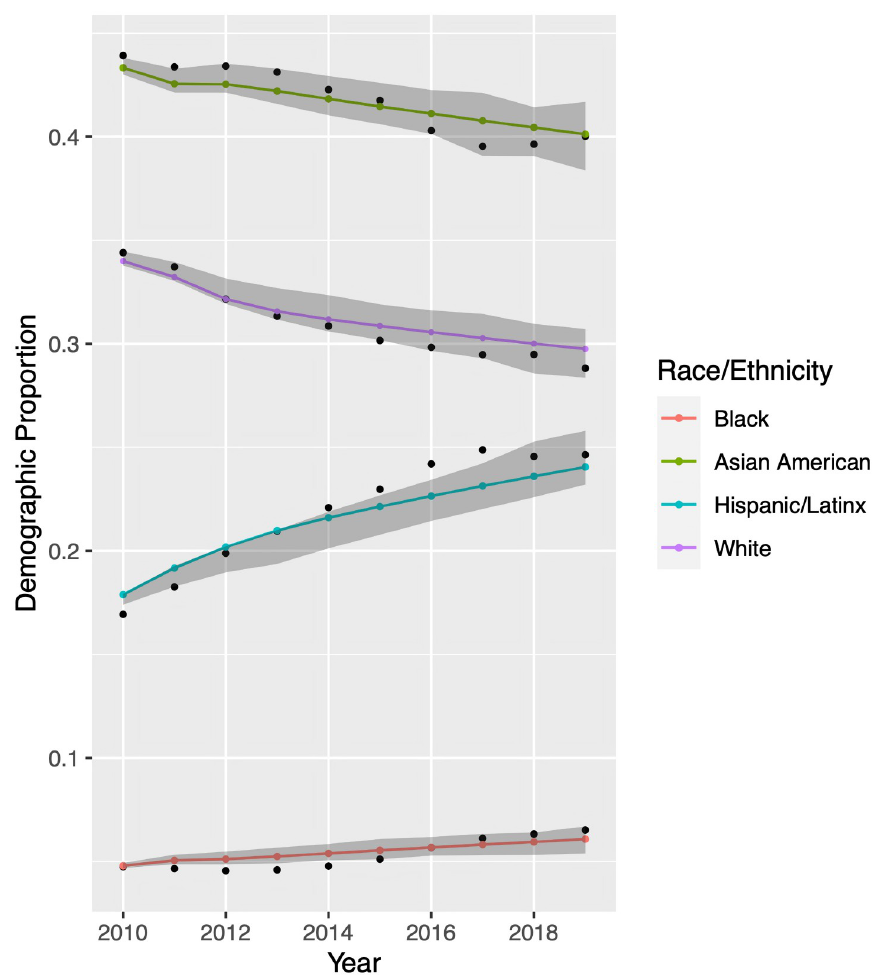
Fig 6. Model validation for University of California-Los Angeles. Historical enrollment records appear as black dots. Colored dots are model output obtained when using the parameters forecast in Inferring Model Parameters. We perform an additional 2800 model simulations using parameter sets generated by Latin hypercube sampling. Grey bands indicate the central 95% of these results. Demographic proportions are relative to each other; see Mathematical